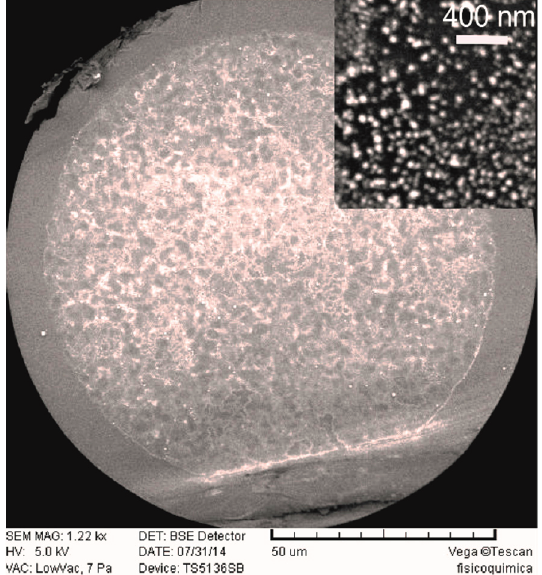
Figure 4. Image of the optical fiber end obtained with